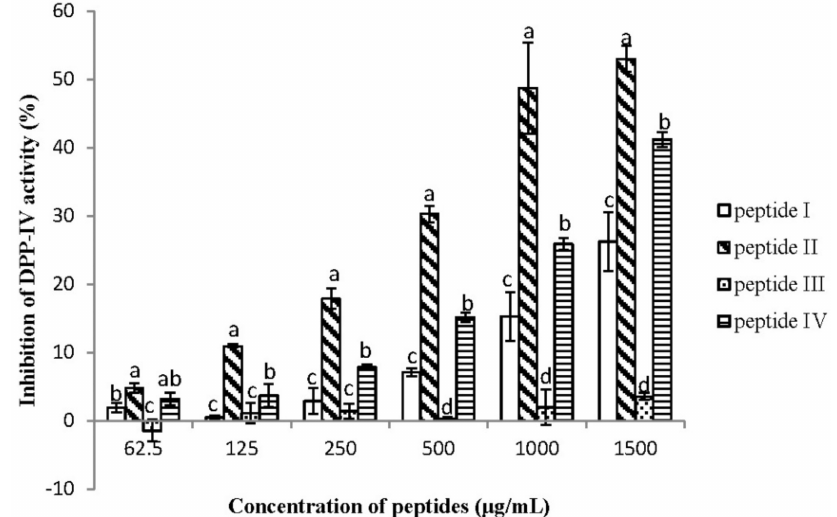
Figure 2. The different inhibitory capability of DPP-IV with respect to peptides I–IV. The inhibition of DPP-IV activities was determined at concentrations of 62.5, 125, 250, 500, 1000, and 1500 µ g/mL respectively ( n = 3). Values are presented as mean ± SD. Bars with different letters are significantly different at p <